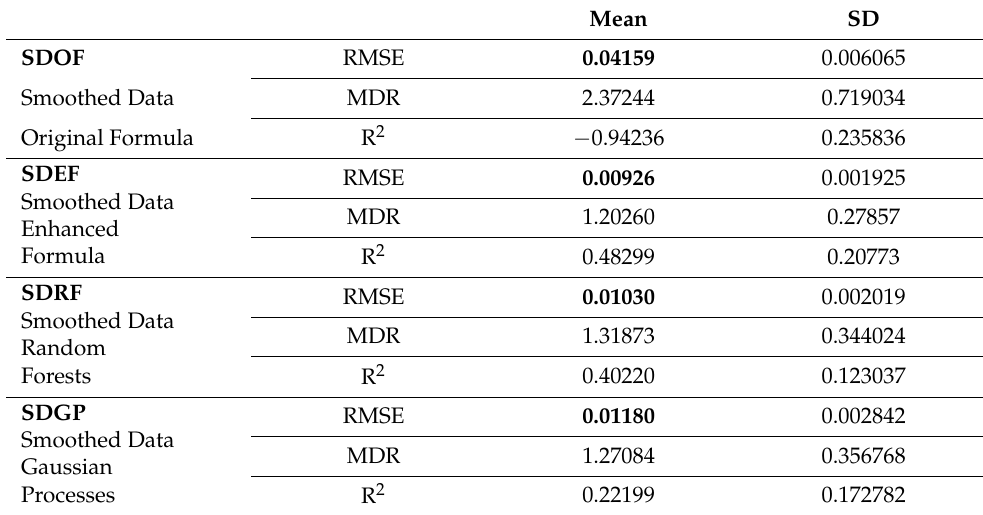
Table 3. Mean and standard deviation of error metrics for smoothed data and for the out-of-the-bag dataset from bootstrap resampling. RMSE units: kg/(s ·